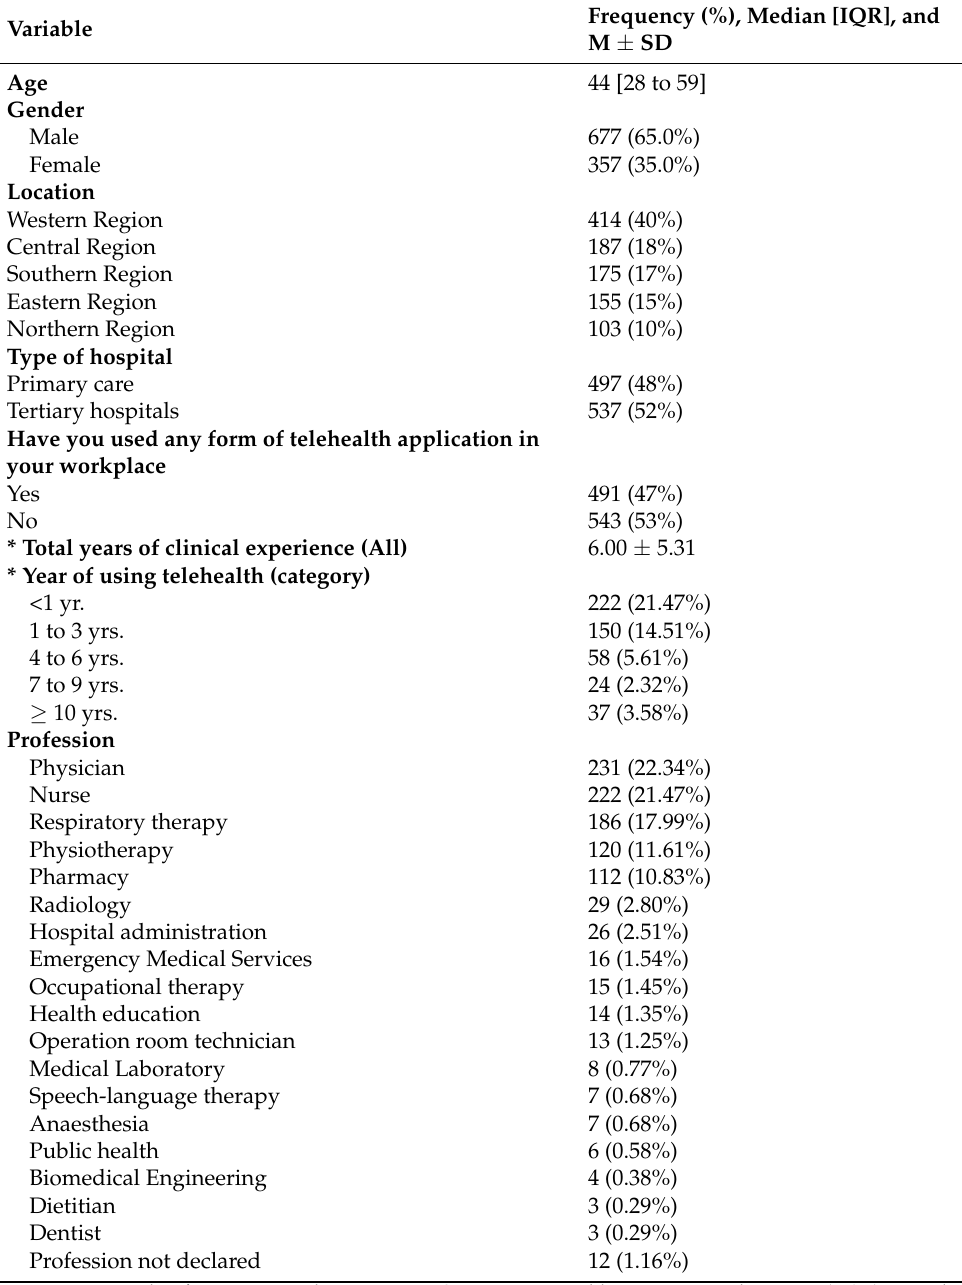
Table 1. Demographic data and characteristics of all study